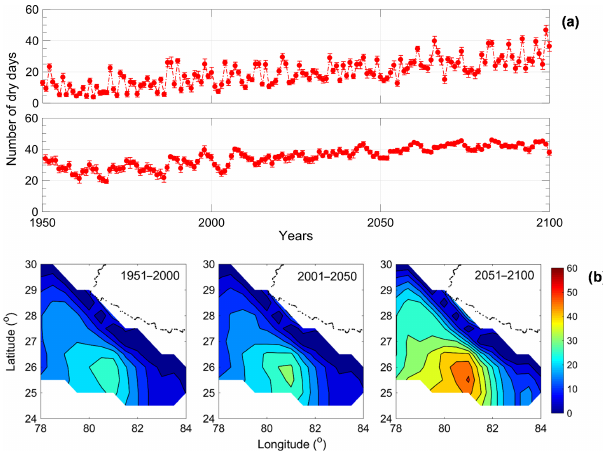
Figure 10. (a) Climatic variations in dry day frequency over regions 1 and 3 containing both historical data (up to 2005) and RCP 8.5 projections (2006–2100) of multimodel mean from three selected GCMs (b) Projected lat–long maps of DDF for all three 50-year periods from 1951 to